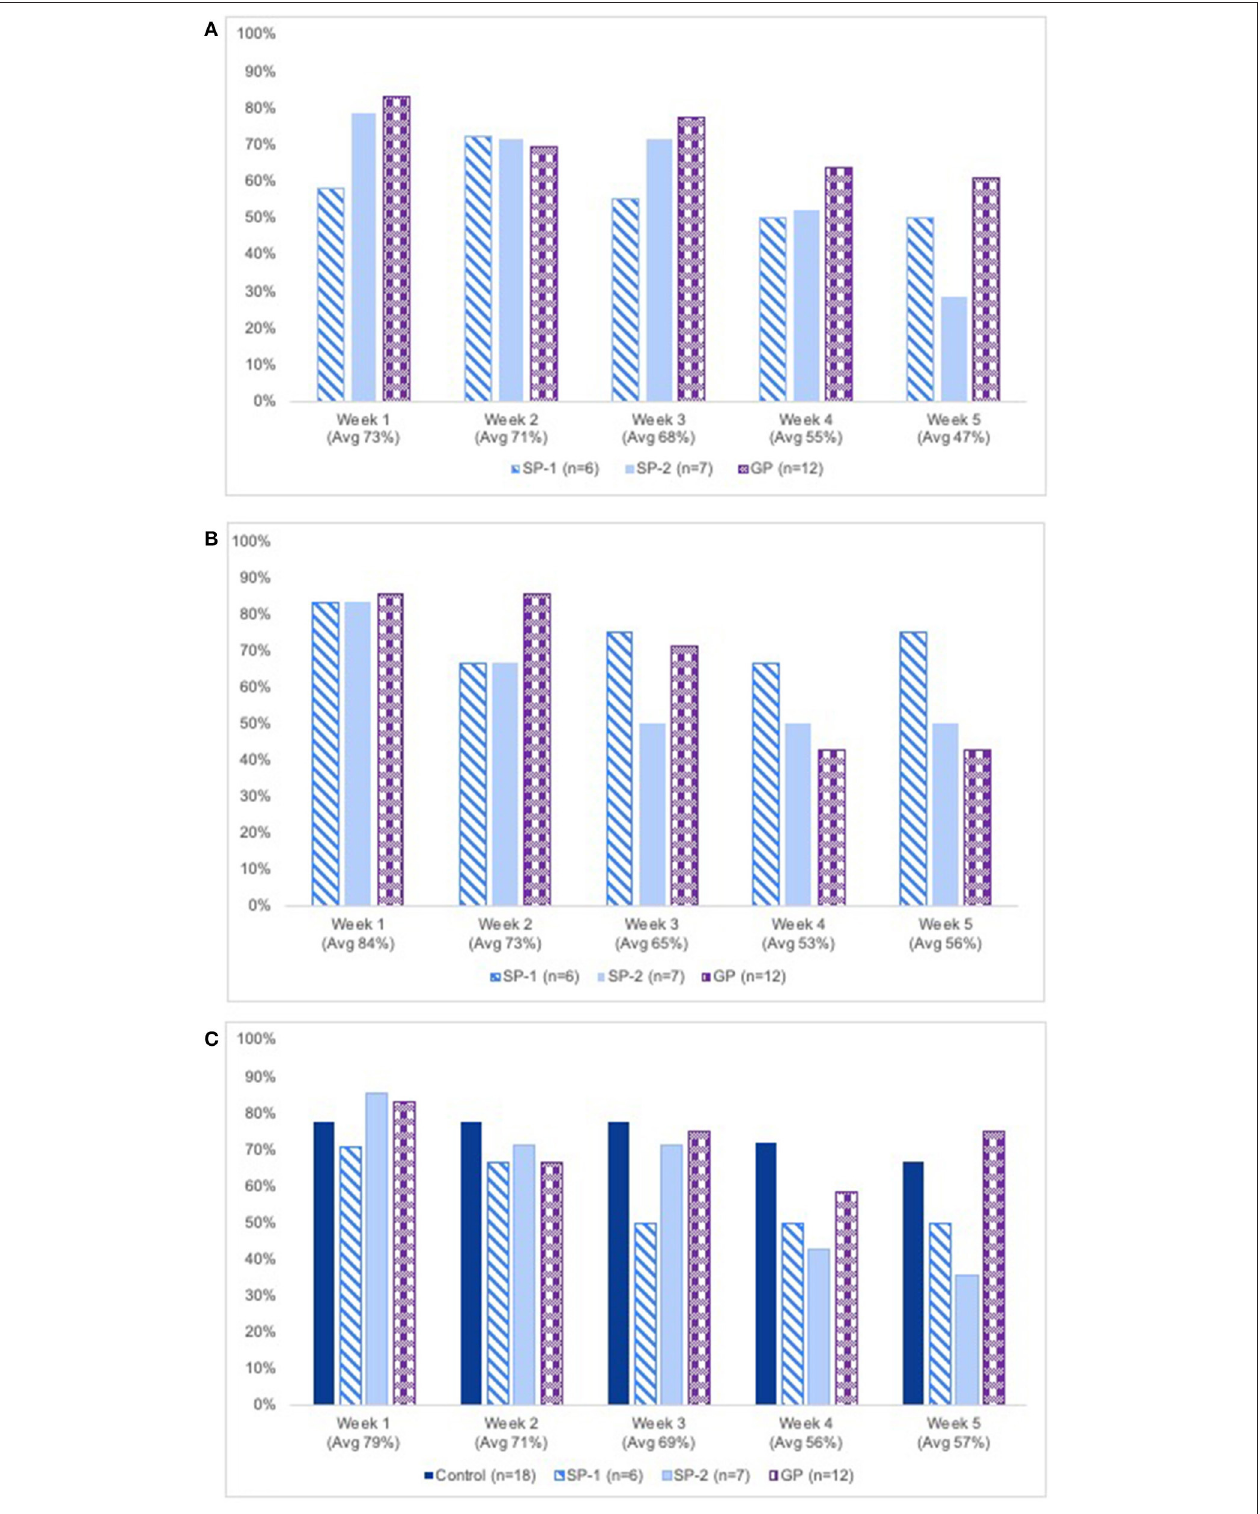
FIGURE 2 | (A) Percent of breathing group participants completing breathing exercises, by class & week. GP, guided-pace breathing group. (B) Percent of breathing group participants completing breath science education videos, by class & week. GP, guided-pace breathing group. (C) Percent of all participants completing STAI-state & CO 2 TT assessments, by class & week. GP, guided-pace breathing group; SP,-1, self-paced group 1; SP,-2, self-paced group 2. CO 2 TT, carbon dioxide tolerance test; STAI, State-Trait Anxiety Inventory.